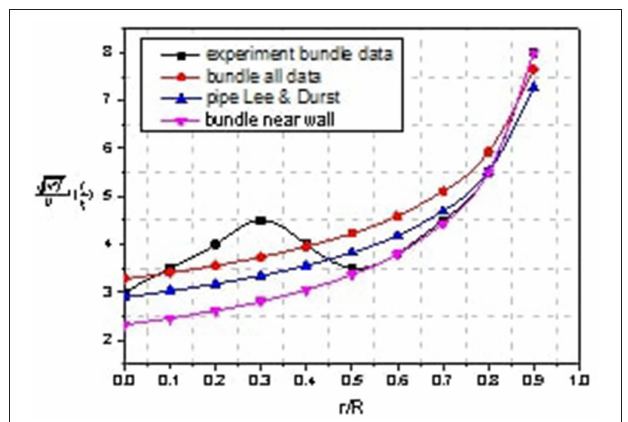
FIGURE 2 | Comparisons of radial turbulence fluctuations and fitted